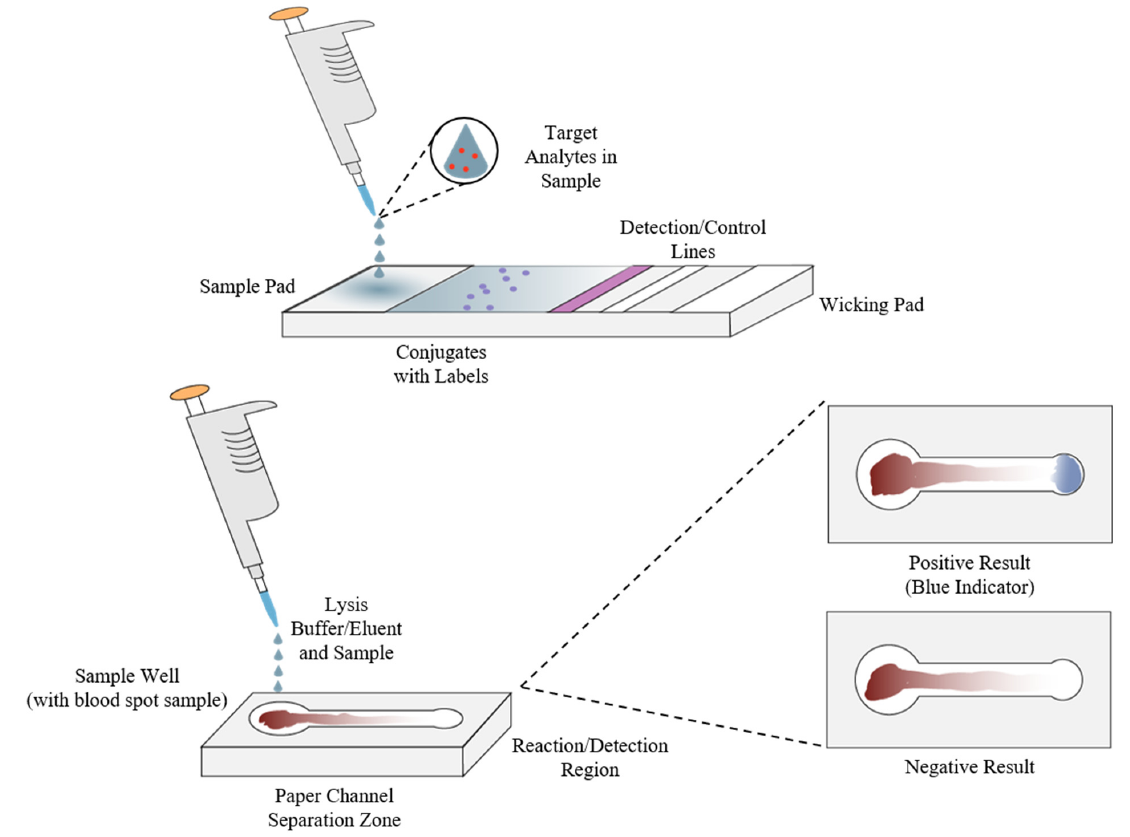
Figure 7. Generalized lateral flow assay (LFA) or dipstick test ( top ) and microfluidic paper-based analytical devices ( µ PADs) used for diagnosis ( bottom ).